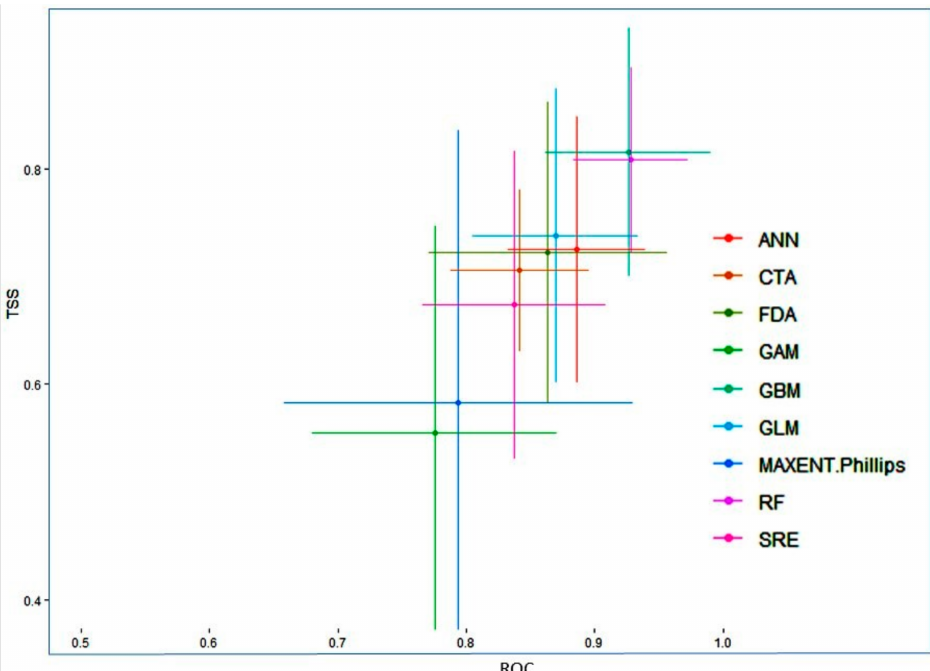
Figure 1. True skill statistics (TSS) and receivers operating characteristic curve (ROC) values of different model